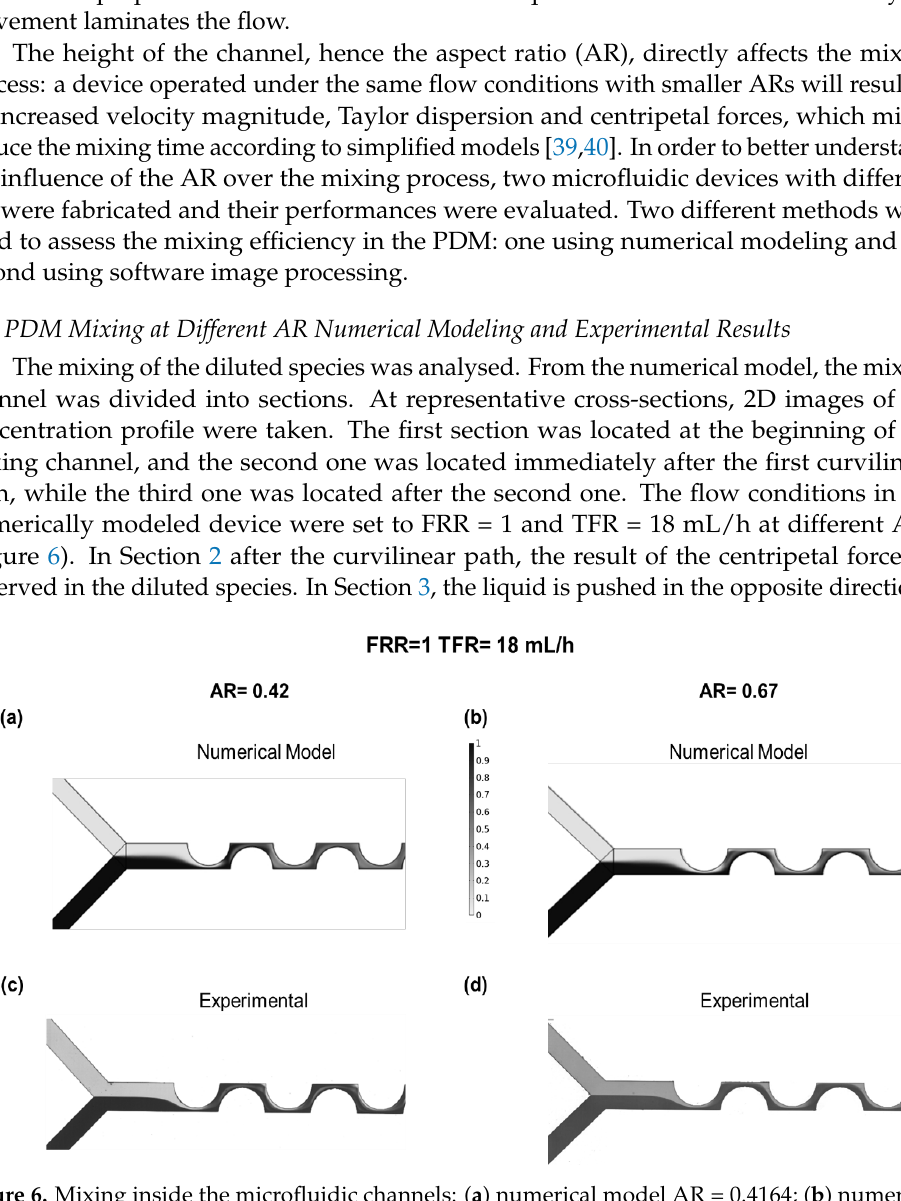
Figure 6. Mixing inside the microfluidic channels: ( a ) numerical model AR = 0.4164; ( b ) numerical model AR = 0.6733; ( c ) experimental AR = 0.42; ( d ) experimental AR =